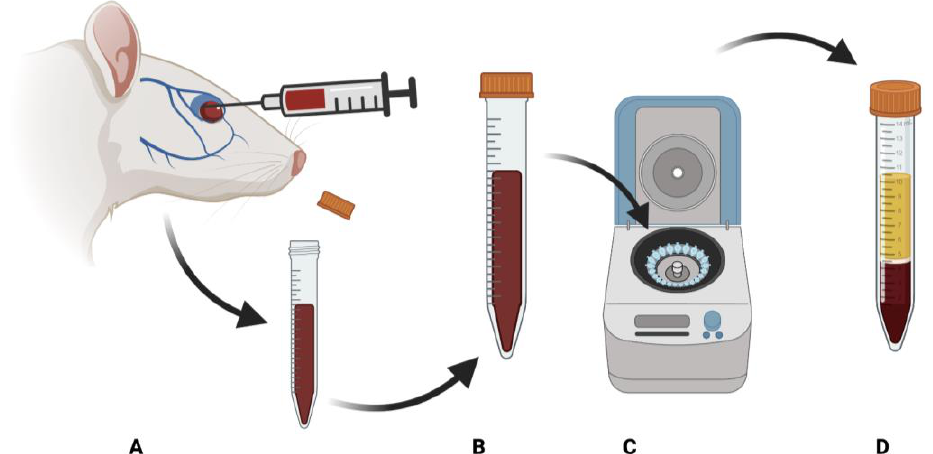
Figure 2. ( A ) Orbital sinus puncture in the rat’s orbital area using a syringe with a needle ranging between 21–23G; ( B ) Blood placed in a tube/falcon (without additives); ( C ) The tube is then quickly placed in the centrifuge, following protocols for PRF production, rpm, time, and RCF; ( D ) PRF is produced after following the previous steps.